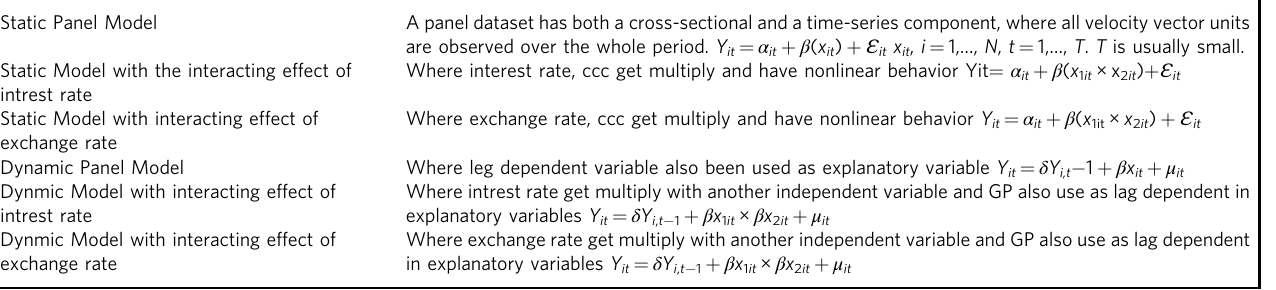
Table 2 Comparison between the different models used in the study for analysis. Static Panel